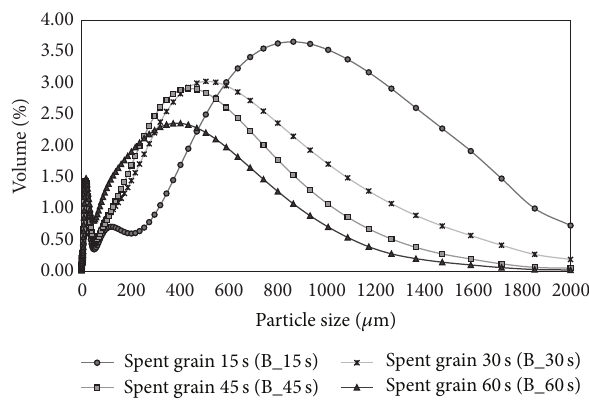
Figure 4: Particle size distribution of spent barley grain used to make barley